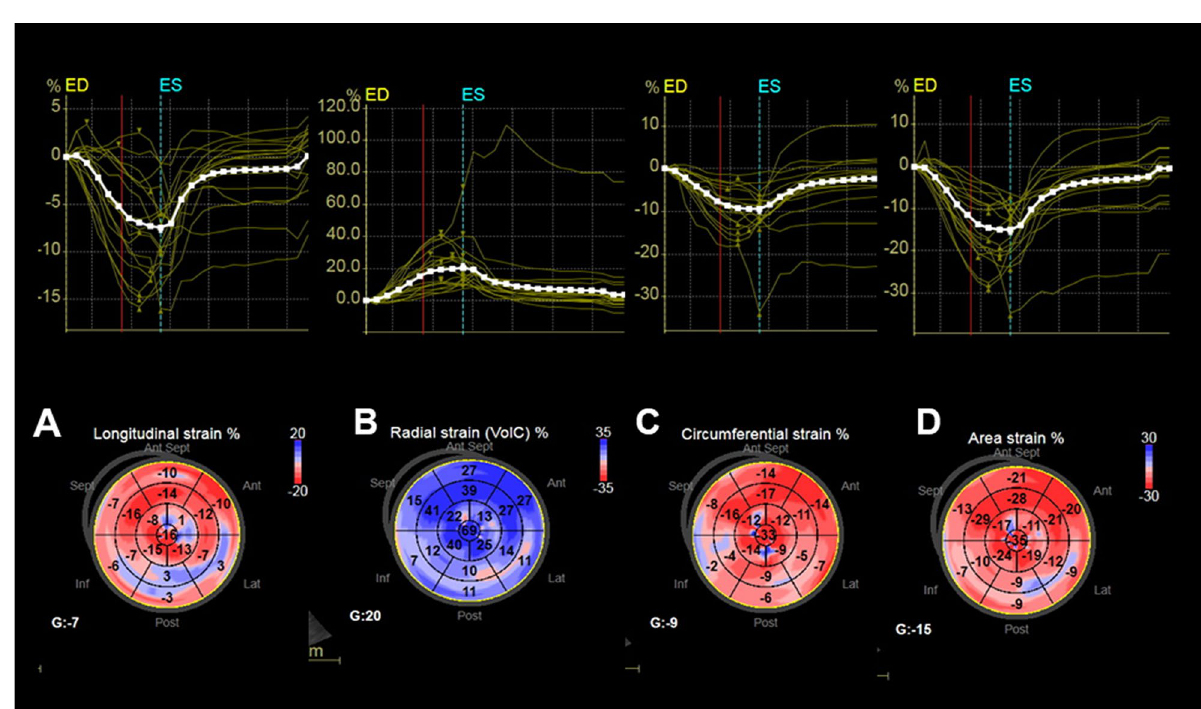
Figure 1. 3D STE images from a patient with CD cardiomyopathy and severe LV dysfunction. ( A ) 3D LV global longitudinal strain = − 7%. ( B ) 3D LV global radial strain = 20%. ( C ) 3D LV global circumferential strain = − 9%. ( D ) 3D LV area strain = − 15%. 3D STE parameters are reduced diffusely. 3D STE Three-dimensional speckle tracking echocardiography, CD Chagas disease, LV left